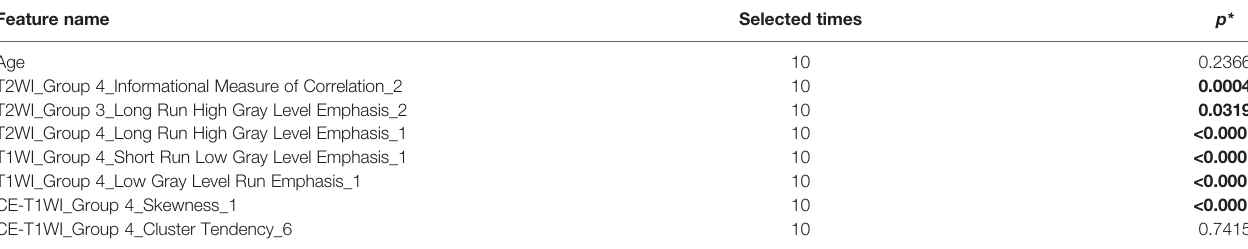
TABLE 2 | Selected valuable features.